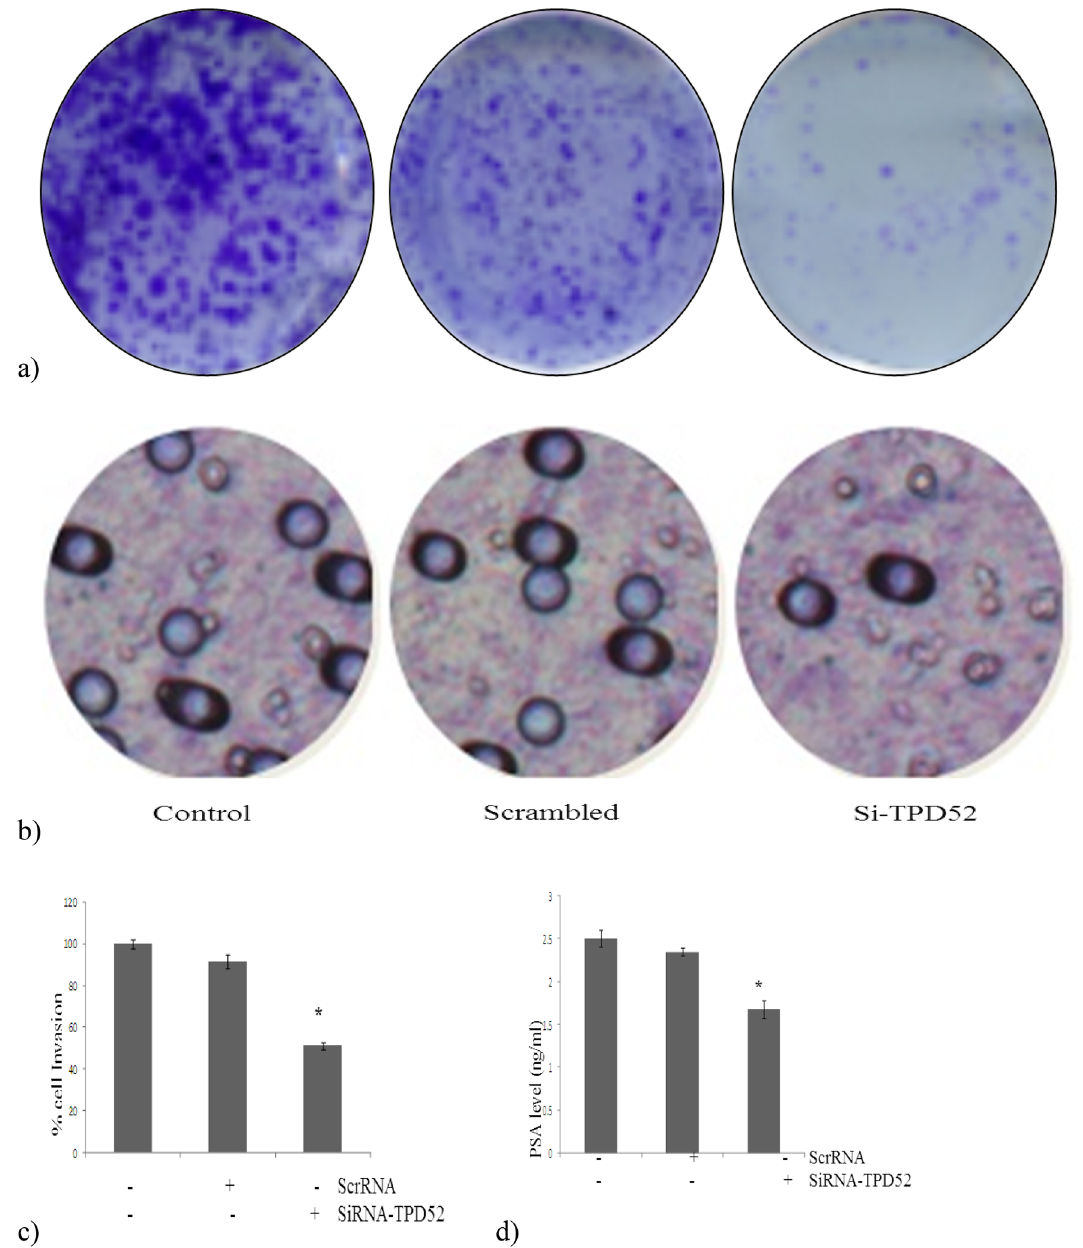
that the first left figure represents untransfected normal CWR22Rν1 cells showing almost 55% of invaded cells, the middle figure represents scrambled RNA transfected cells showing almost the same number of invasive cells as that of normal control and third is SiRNA-TPD52 transfected CWR22Rν1 cells which show only 10% of cell invasion. ( c ) Quantitative analysis of cell invasion by dissolving stained cells in 10% acetic acid (100–200 μl/well) and transfer a consistent amount of the dye/solute mixture to a 96 well plate for a calorimetric reading of OD at 560 nm (p < 0.021). ( d ) ELIZA for serum PSA secretion of TPD52-siRNA down-regulated CWR22Rν1 cells. Effect of TPD52-siRNA down-regulated CWR22Rν1 cells on serum PSA secretion in media (p < 0.0032). All experiments (A-F) were done in